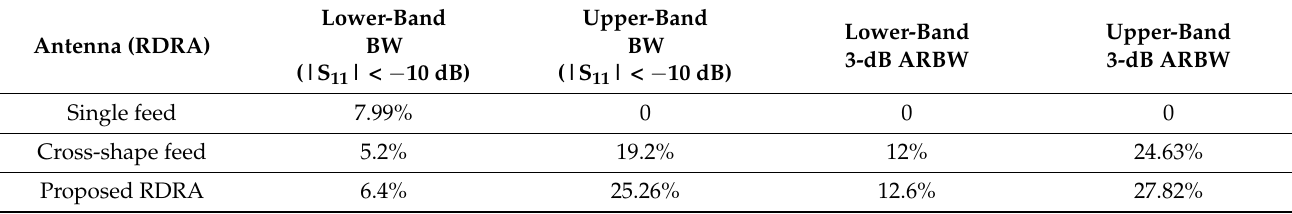
Table 3. Performance of all antennas (frequency unit: